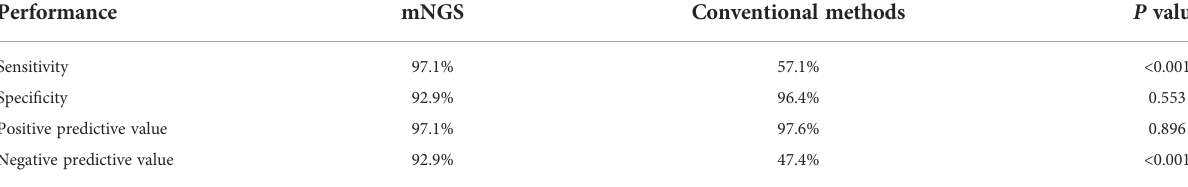
TABLE 3 Diagnostic performance of mNGS and conventional methods.